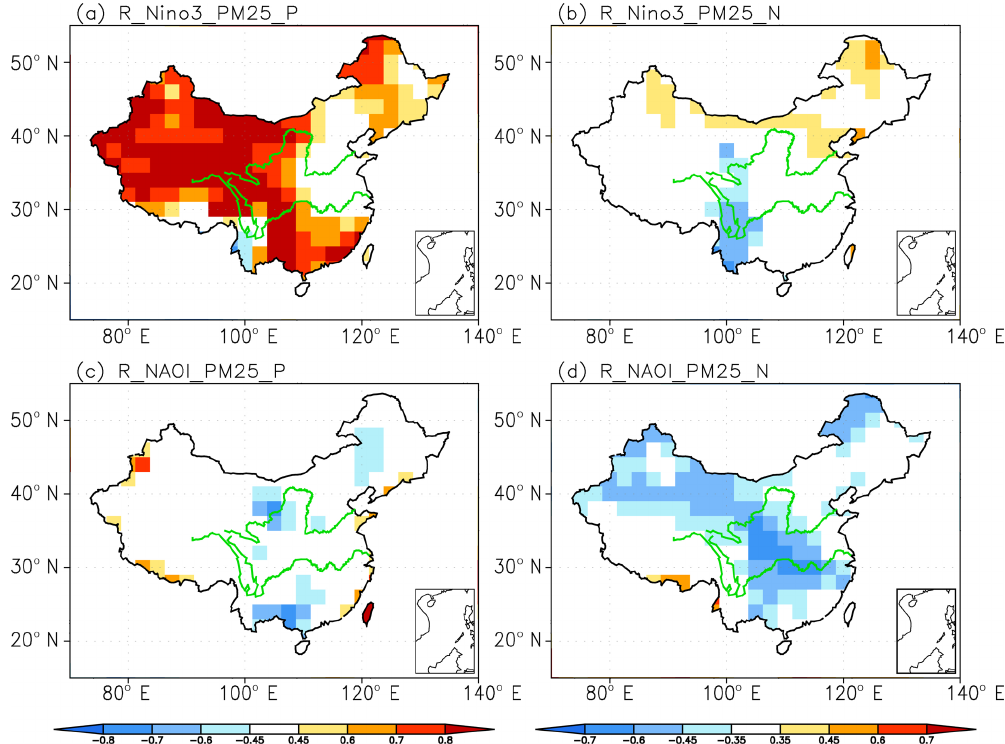
Figure 4. Spatial distribution of the correlation coefficients between (a) positive and (b) negative Niño3 index values and surface-layer PM 2 . 5 concentrations. Panels (c, d) are as (a, b) but for the NAOI. Color shading indicates a significant correlation (0.35 and 0.45 are the critical values for significance at the 0.2 and 0.1 level, respectively).